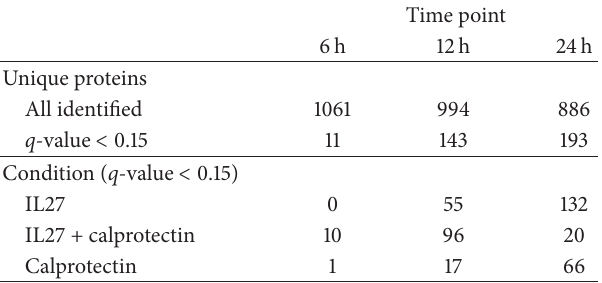
Table 1: Number of unique identified proteins without and with q -value cut-off of 𝑞 < 0.15 of IL27 (30ng/mL) ± calprotectin (1 𝜇 g/mL)-stimulated HUVECs for 6, 12, and